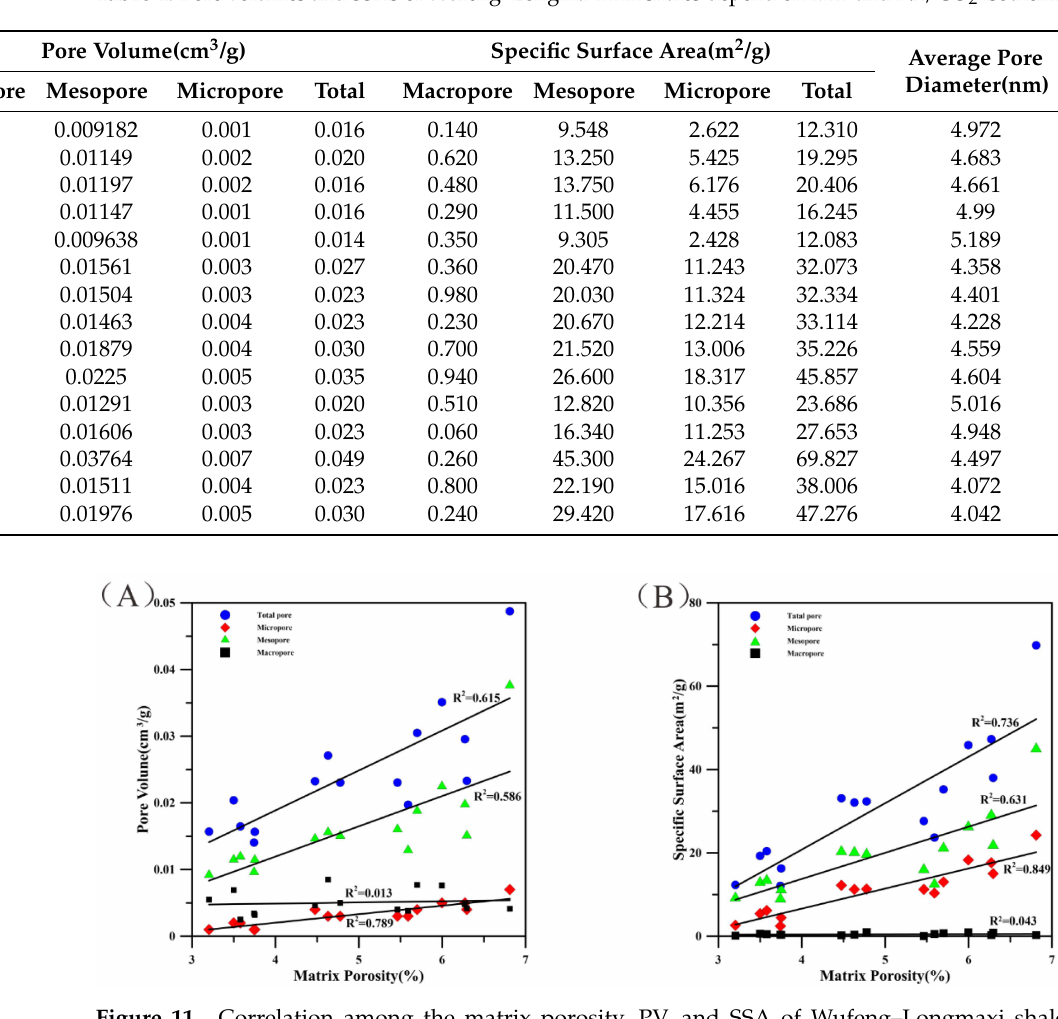
Figure 11. Correlation among the matrix porosity, PV, and SSA of Wufeng–Longmaxi shales. ( A ) Correlation between matrix porosity and pore volume; ( B ) Correlation between matrix porosity and specific surface